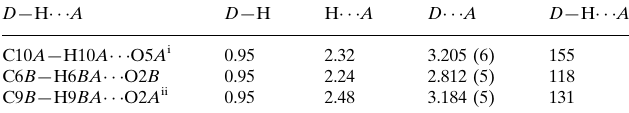
Hydrogen-bond geometry (A˚ , (cid:1)